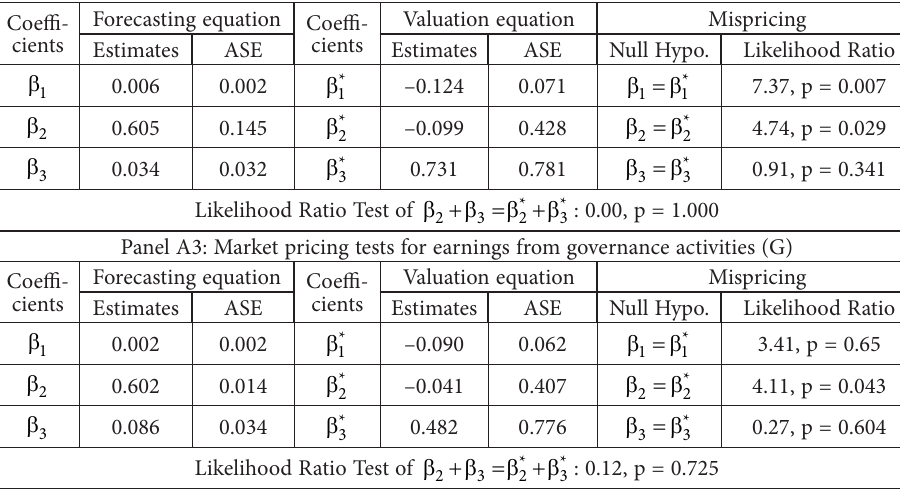
Panel B1: Market pricing tests for the components of earnings from environmental activities (E)